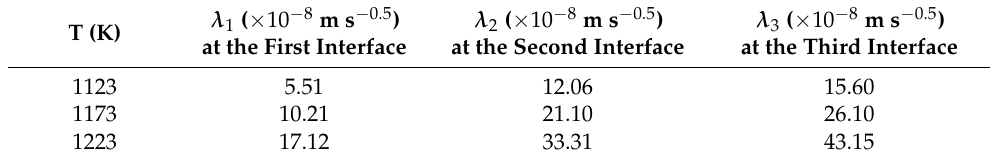
Table 1. New values of experimental kinetics constants fitted with Equations (9)–(11). T (K)